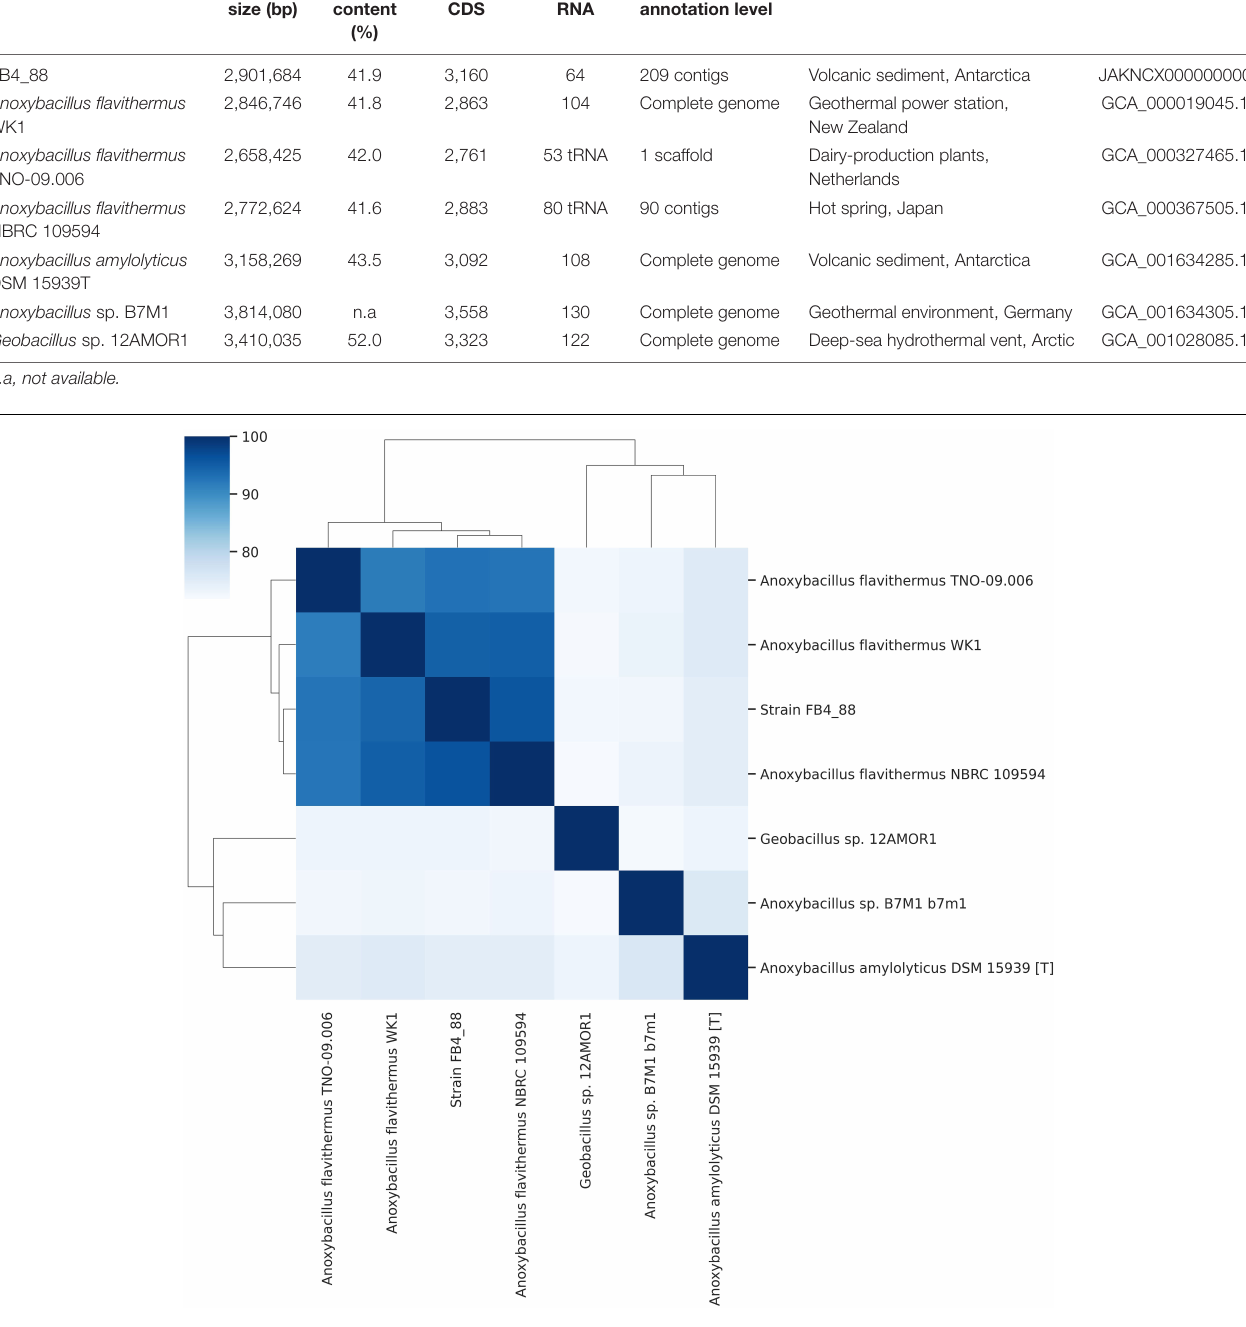
other geothermal environments in Antarctica (Bargagli et